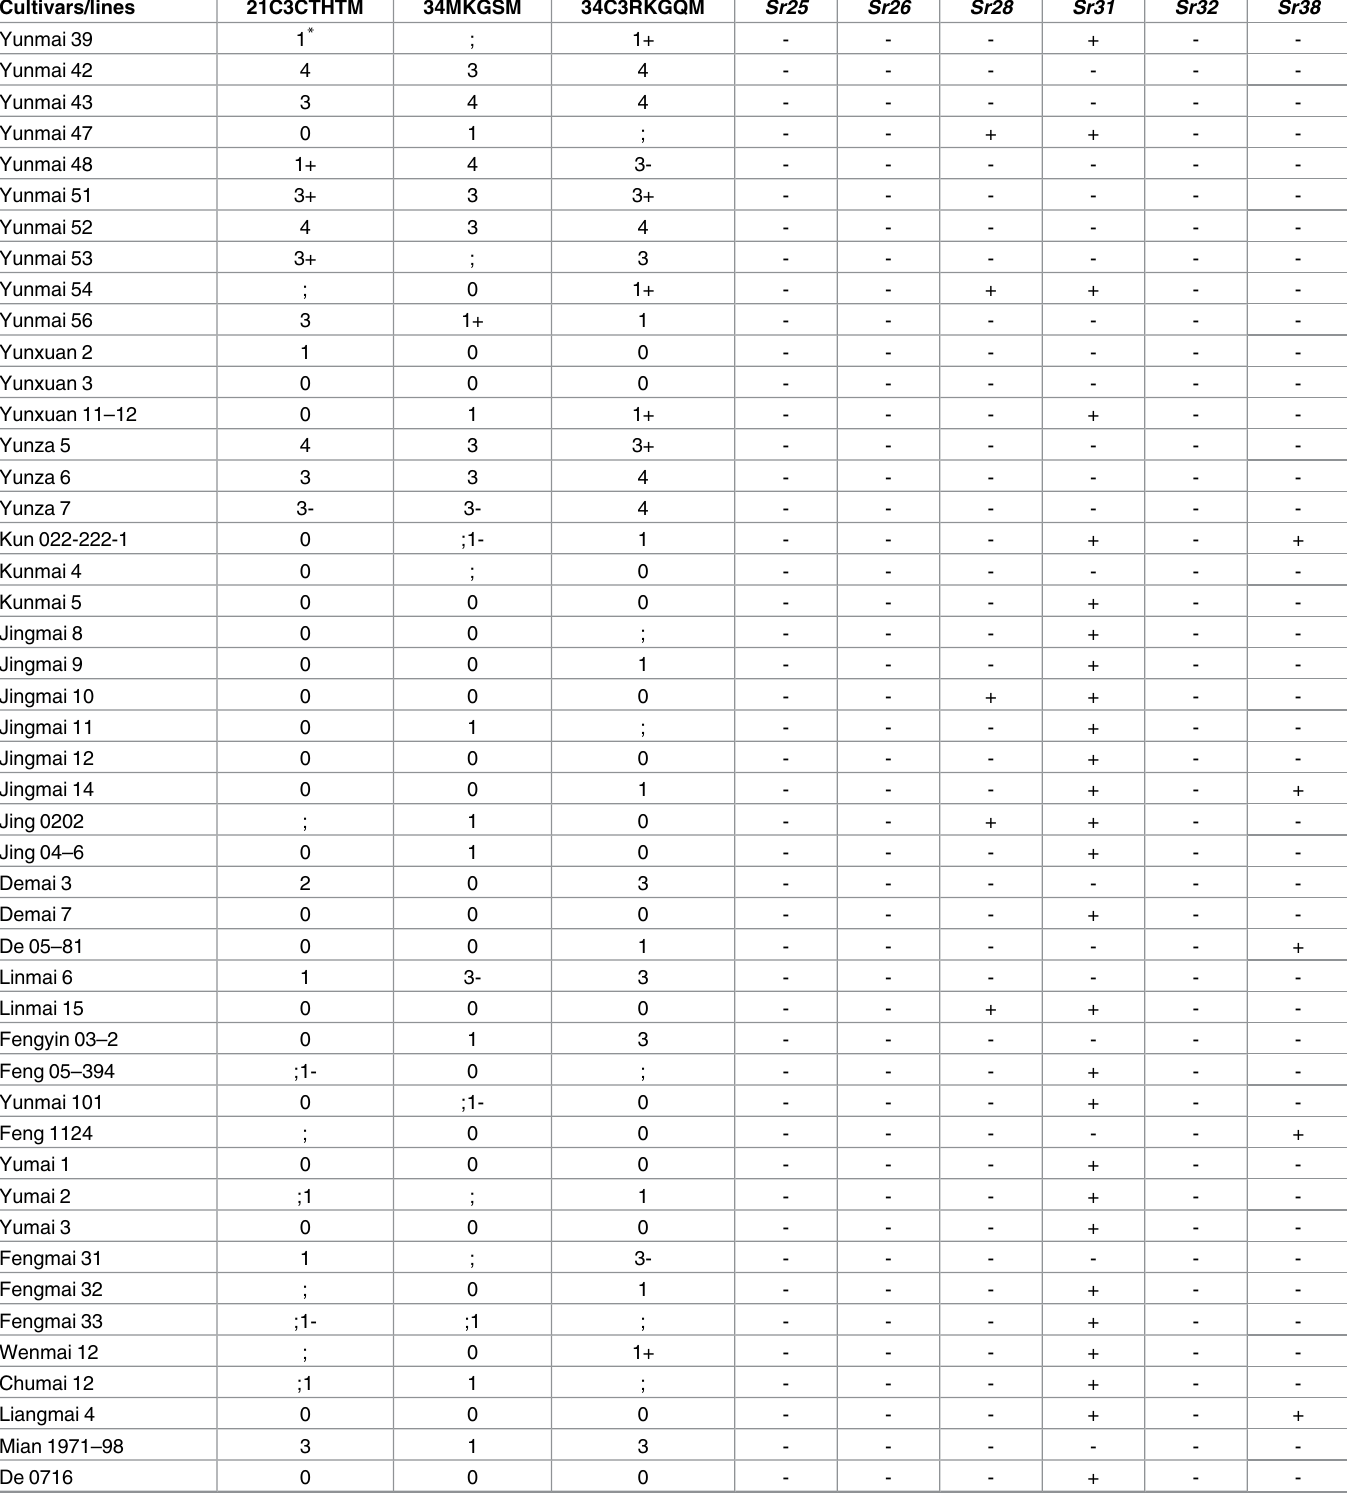
Table 4. Results for wheat seedling resistance and molecular detection. Cultivars/lines 21C3CTHTM 34MKGSM